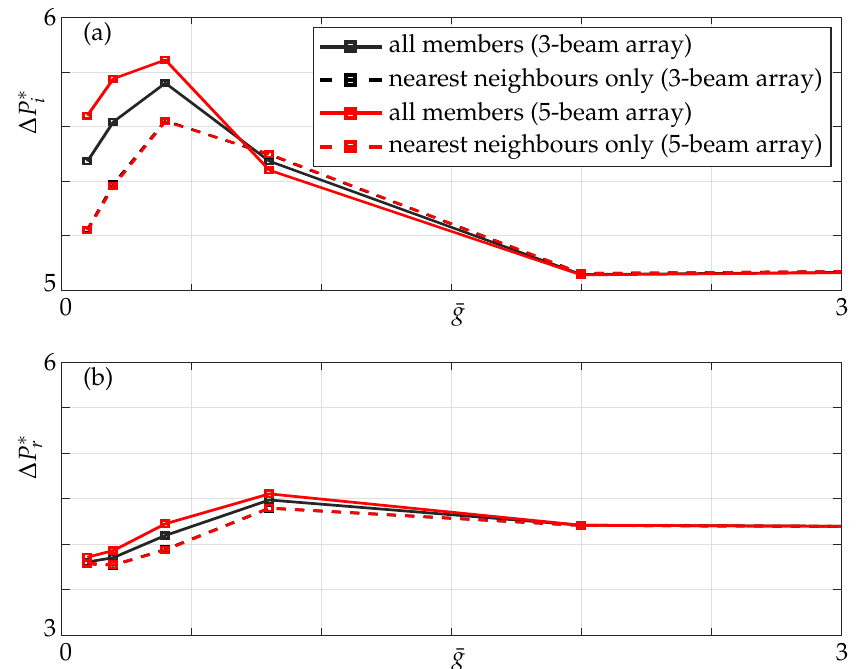
Figure 17. ( a ) Imaginary and ( b ) Real parts of pressure at the mid point of active beam in a three- (black) and a five-beam (red) array for different gaps with only nearest neighbours (dashed line) and all members incorporated (solid line) at Re =